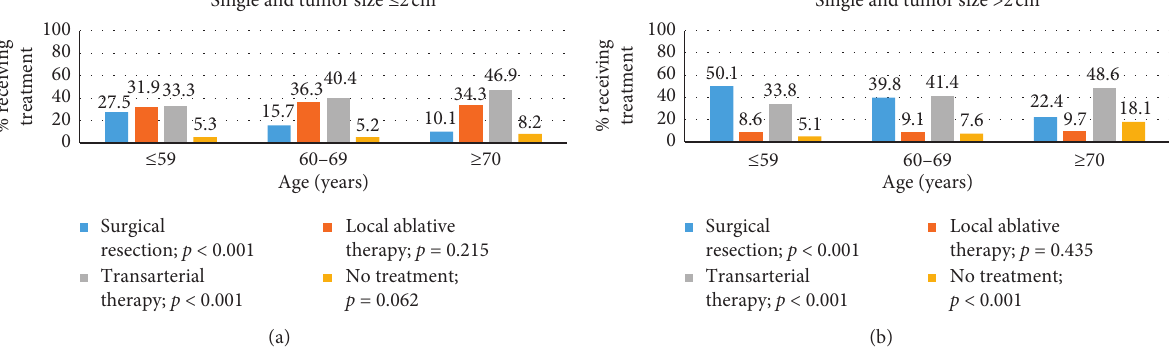
Figure 1: Proportion of the treatments performed for a single lesion according to age group. (a) Tumor size ≤ 2cm for surgical resection ( p < 0 . 001), local ablative therapy ( p � 0 . 215), transarterial therapy ( p < 0 . 001), and no treatment ( p � 0 . 062). (b) Tumor size > 2cm for surgical resection ( p < 0 . 001), local ablative therapy ( p � 0 . 435), transarterial therapy ( p < 0 . 001), and no treatment ( p < 0 . 001).